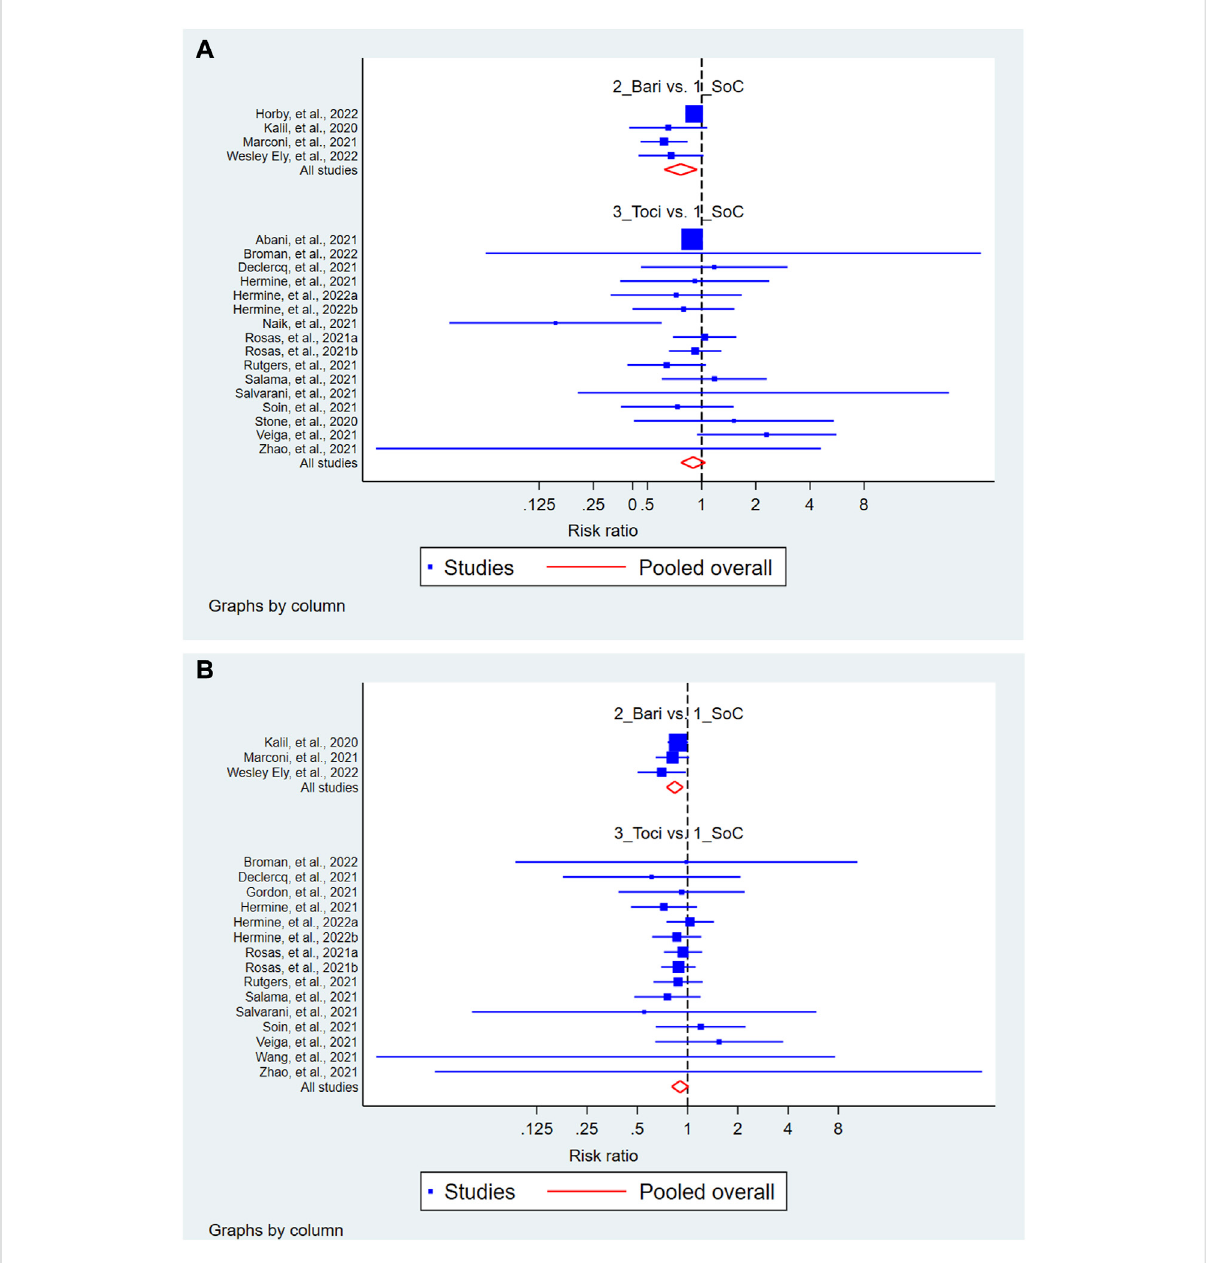
Forest of the network meta-analysis showing the 28-day mortality (A) and serious adverse events (B) following treatment with baricitinib and tocilizumab as compared to that following treatment with the standard of care